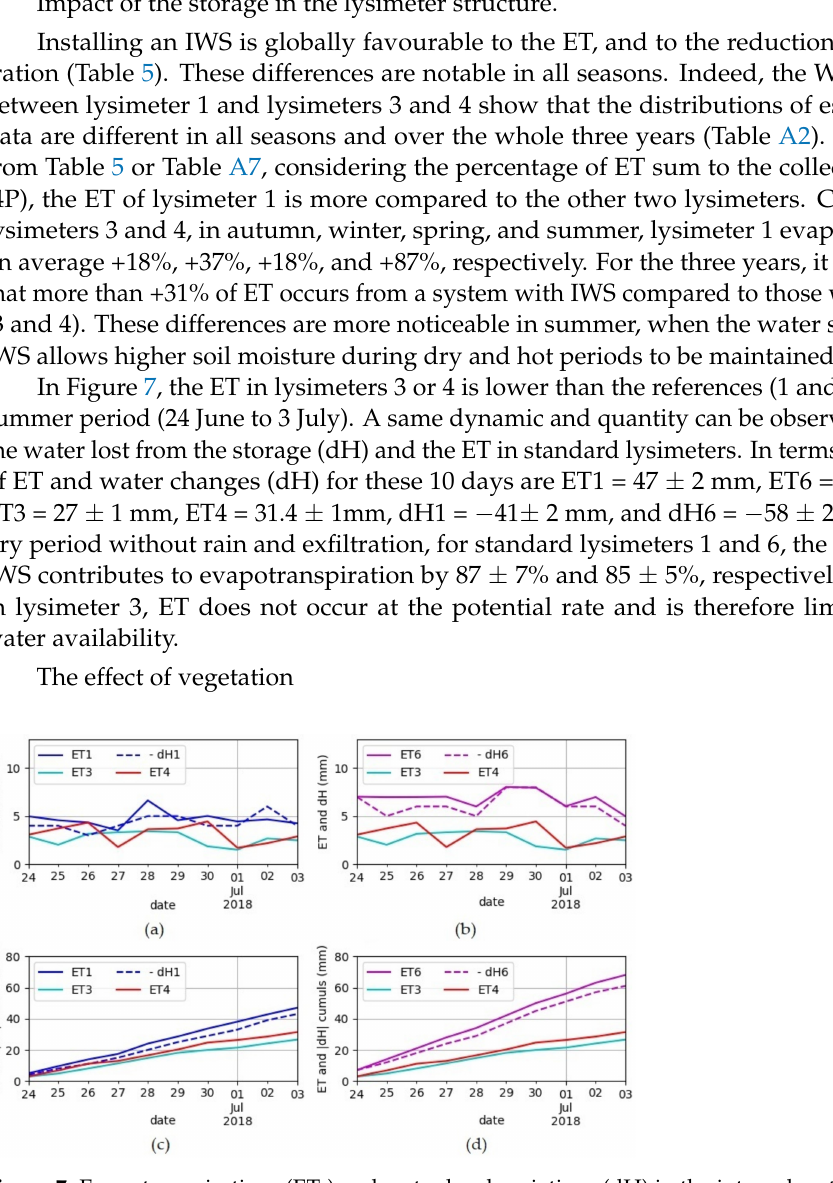
Figure 7. Evapotranspirations (ETs) and water level variations (dH) in the internal water storage for lysimeters 1, 3, and 4 ( a ) and lysimeters 6, 3, and 4 ( b ) during a summer period (24 June to 3 July 2018). ( c , d ) show cumulative values for ETs and | dH | , respectively, for lysimeters 1, 3, 4, and lysimeters 6, 3, and